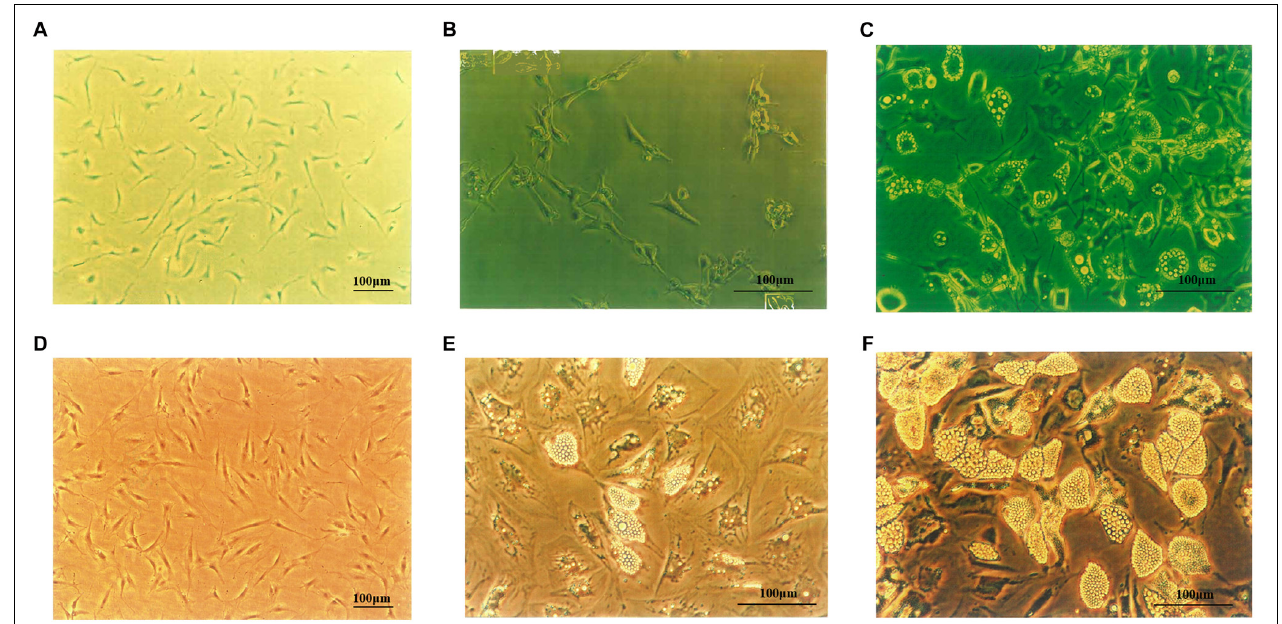
FIGURE 1 | 3T3-L1 and human primary preadipocytes proliferation and differentiation. (A) 3T3-L1 preadipocyte on Day 4 ( × 100). Adipocytes on Day 4 (B) and Day 14 (C) after inducing differentiation ( × 200). (D) Human primary preadipocyte on Day 8 ( × 100). Adipocytes on Day 10 (E) and Day 18 (F) after inducing differentiation ( × 200). Magnification: × 100 or ×